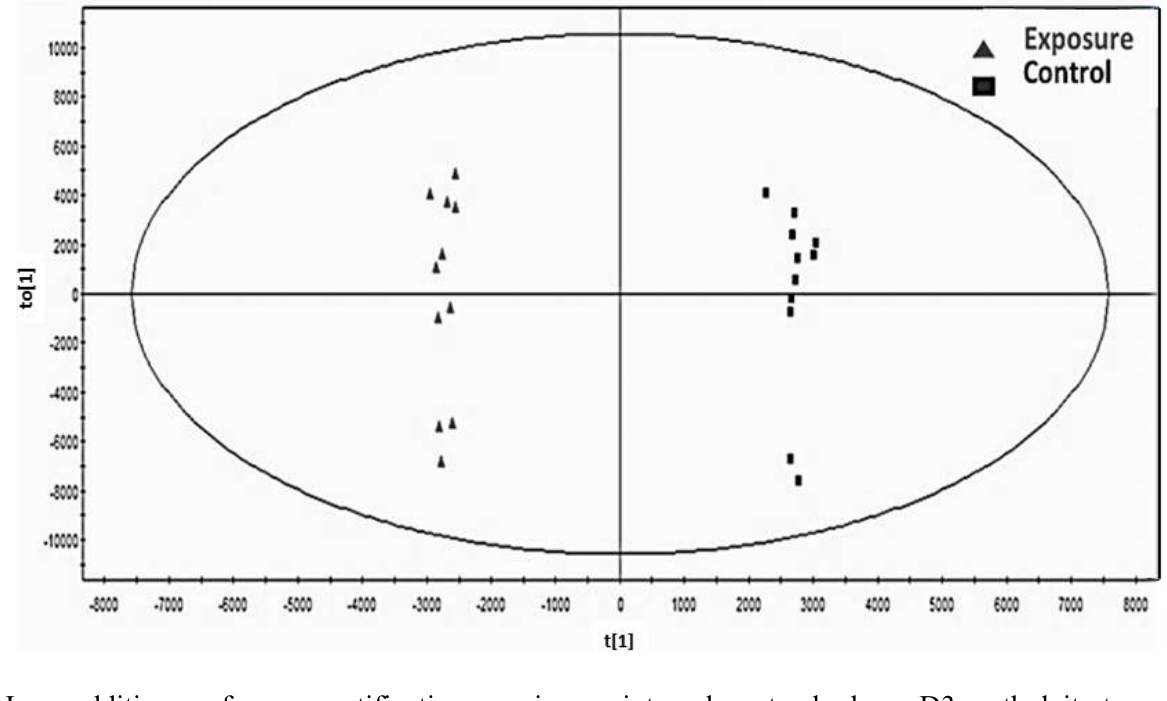
Figure 1. OPLS-DA score plot shows complete discrimination between the Cd exposure group (  ) and control group (  ) with no variation between two